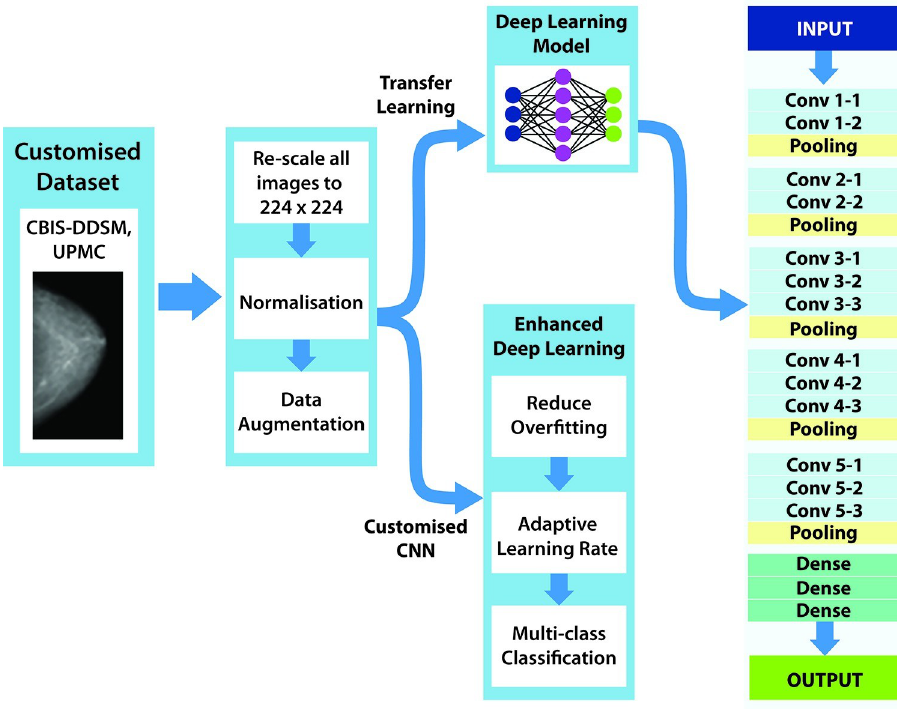
Fig 1. Architecture of the proposed